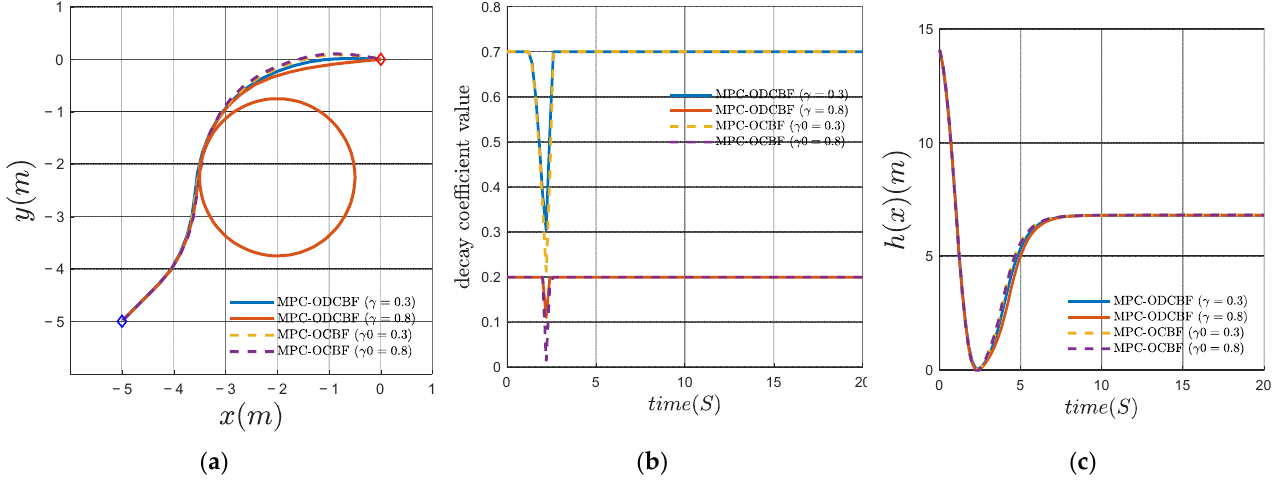
Figure 5. Compare the user-defined obstacle avoidance behaviors generated by MPC-ODCBF and MPC-OCBF: ( a ) the trajectory of MPC-ODCBF and MPC-OCBF; ( b ) the optimized decay coefficient of MPC-ODCBF and MPC-OCBF; ( c ) the CBF h(x) values of MPC-ODCBF and MPC-OCBF.